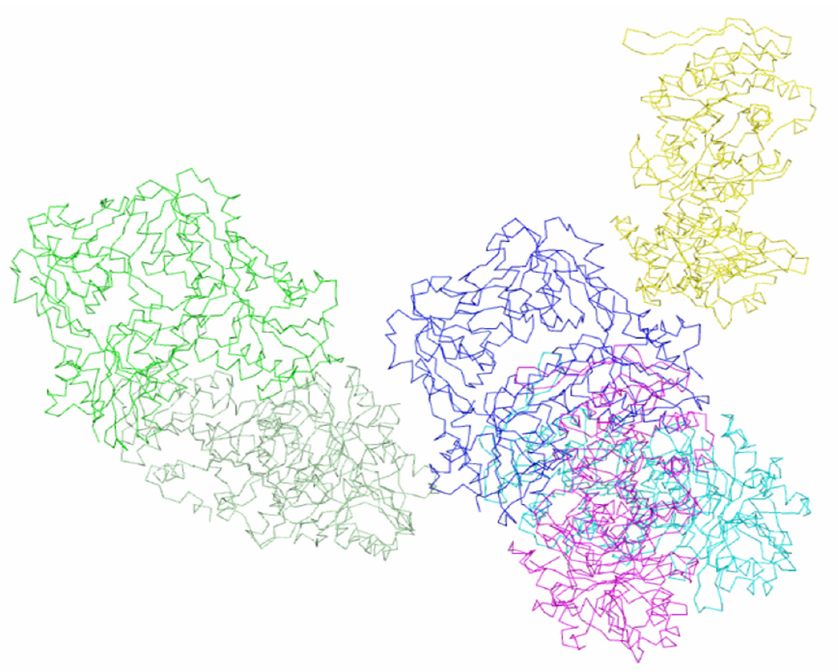
Figure 5. Hexameric enzyme molecule and subunits of symmetric related molecules in contact with it in the crystalline modification P4 1 2 1 2 . it in the crystalline modification P4 1 2 1 2